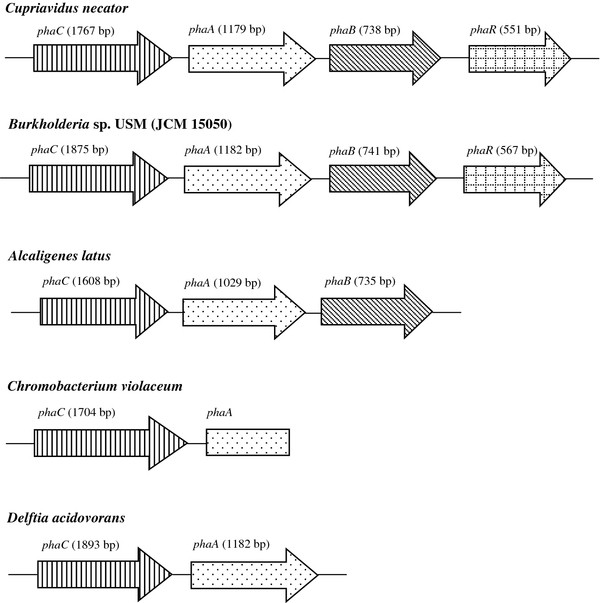
Molecular organizations of PHA biosynthetic genes in Burkholderia sp. USM (JCM 15050) and other bacteria containing type I PHA synthase (Choi et al., [1998]; Kolibachuk et al., [1999]; Rehm & Steinbüchel, [2002]; Sudesh et al., [1998]).